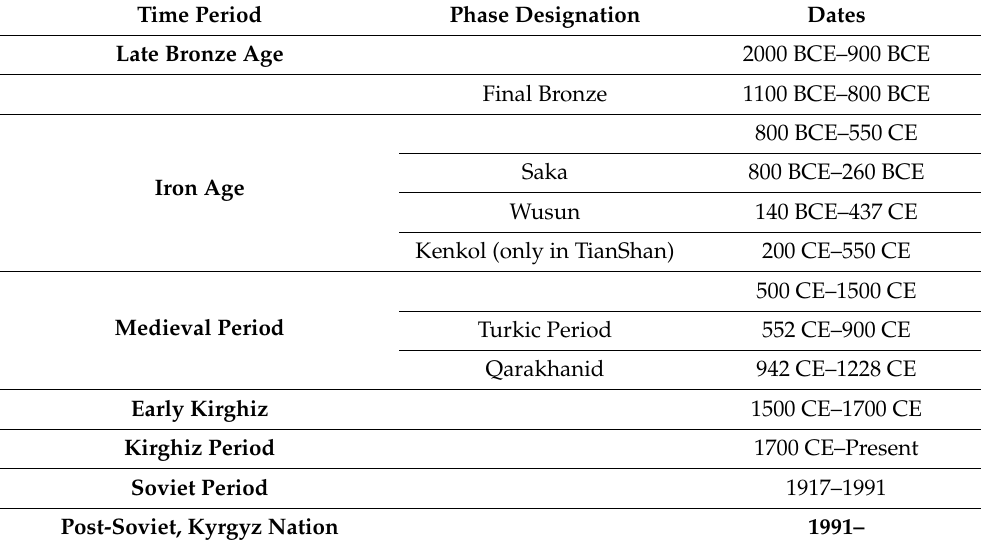
Table 1. Time Periods, Phase Designations, and Dates used for the Juuku and Lower Kizil Suu